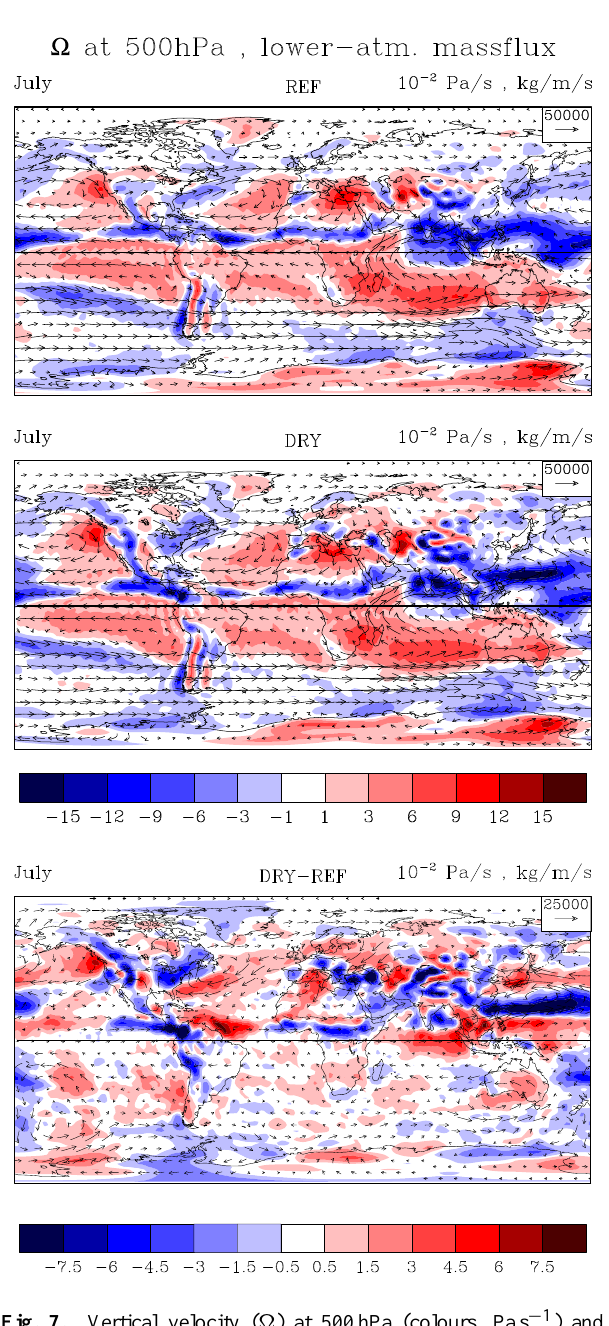
Fig. 7. Vertical velocity ( (cid:127) ) at 500hPa (colours, Pas − 1 ) and horizontal total mass flux in the lowest 13 model levels (arrows, kgm − 1 s − 1 ) in July in the REF experiment (top panel), in the DRY experiment (middle panel), and the difference between the two (bot- tom panel). The lowest 13 model levels correspond approximately to the lower half of the atmosphere. Hence, the vertical velocity at 500hPa approximately corresponds to the divergence of the shown mass flux. Note that the scale for both (cid:127) and the mass flux are changed by a factor 2 in the bottom panel to make the differences better visible. See Fig. S6 in the Supplement for